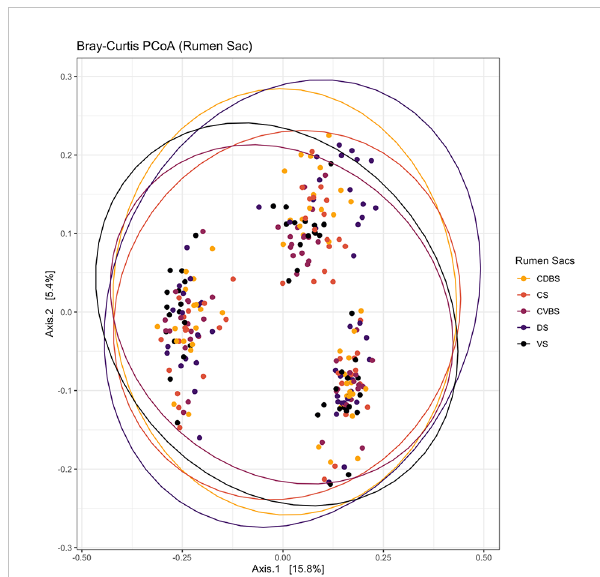
FIGURE 4 Bray-Curtis principal coordinates analysis among each rumen sac and their bacterial community. Beta-diversity was measured with the Bray-Curtis distances and visualized with a principal coordinates analysis (PCoA). The CDBS is shown in orange, CS is shown in red, CVBS is shown in light purple, DS is shown in dark purple, and VS is shown in black. The circles represent a 95% con fi dence interval around the means of each rumen sac. No signi fi cant distance measurement was determined among the rumen sacs (P >